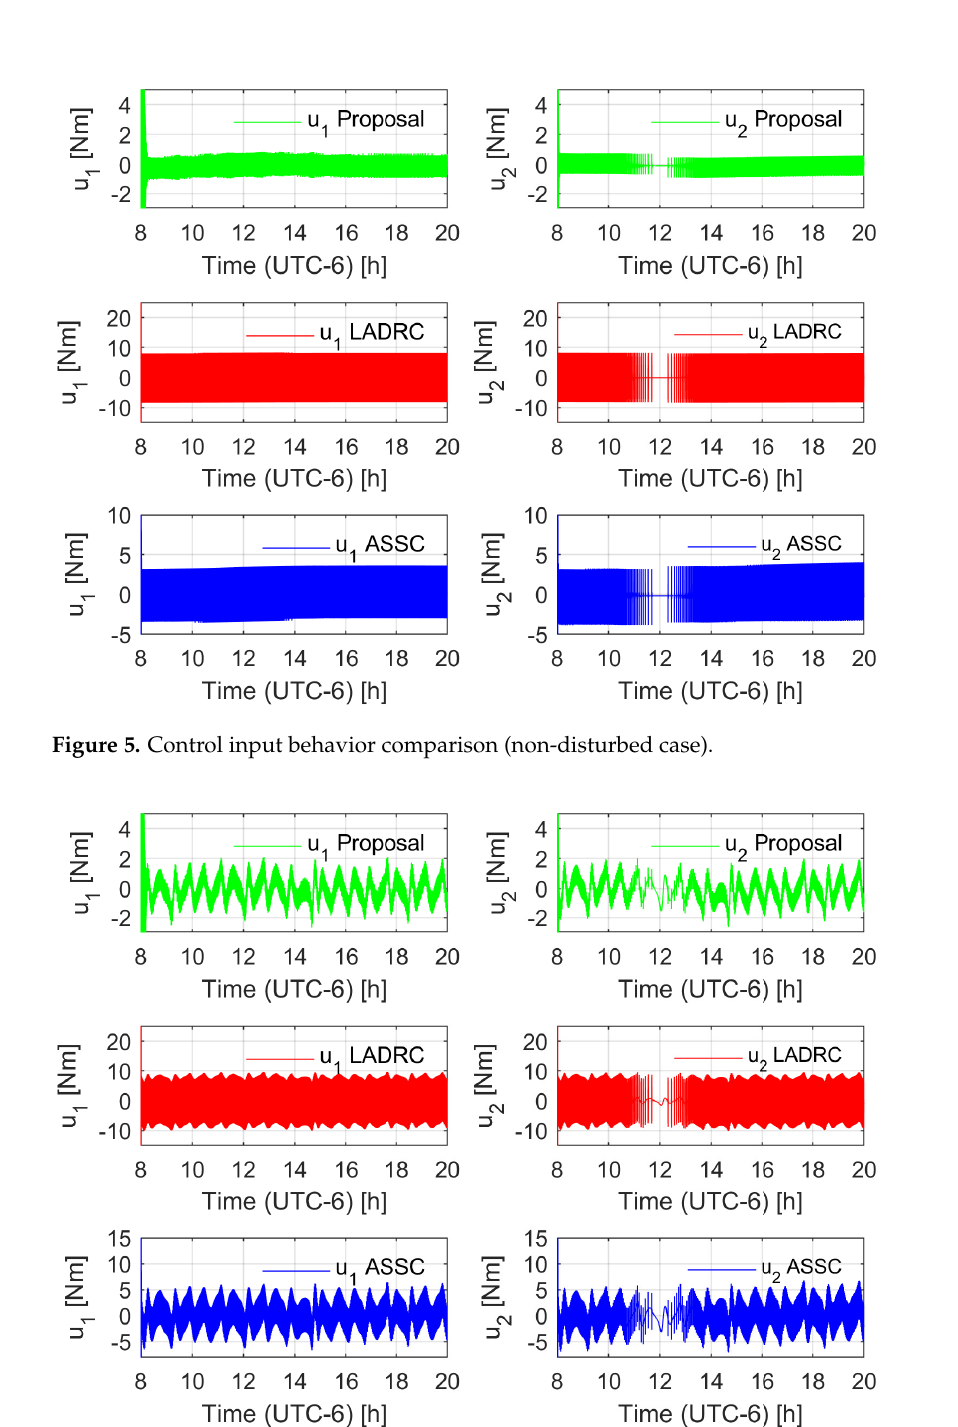
Figure 6. Control input behavior comparison (disturbed